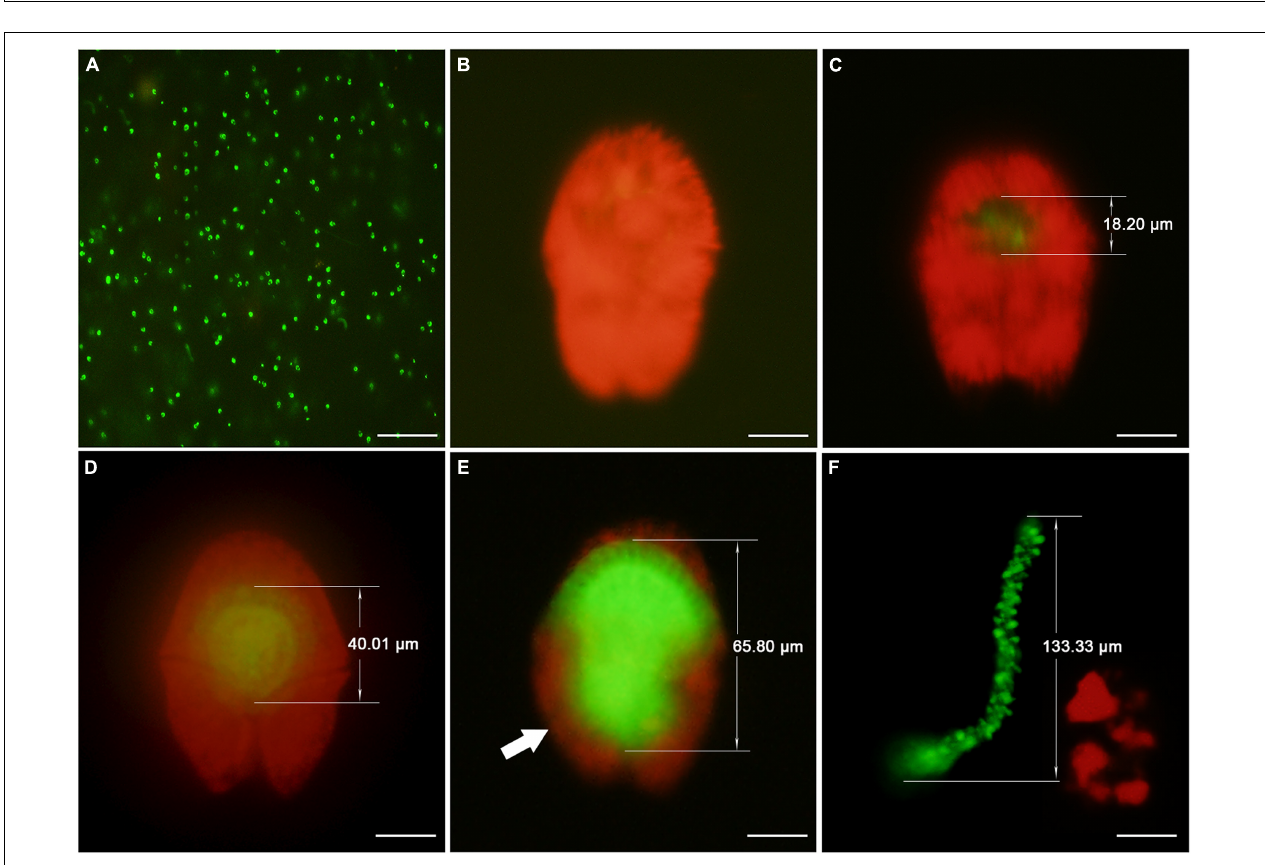
FIGURE 1 | Time-course studies of Akashiwo sanguinea infected with Amoebophrya sp. at a dinospore: host ratio of 10: 1. (A) Total A. sanguinea cell concentrations in control, filtrate-added and infected cultures. (B) Estimation of numbers of dinospores, infected and uninfected hosts in infected cultures, with the prevalence (data on the column). No infected cells or dinospores were detected in the filtrate-added and control cultures. Error bars indicate the standard error.